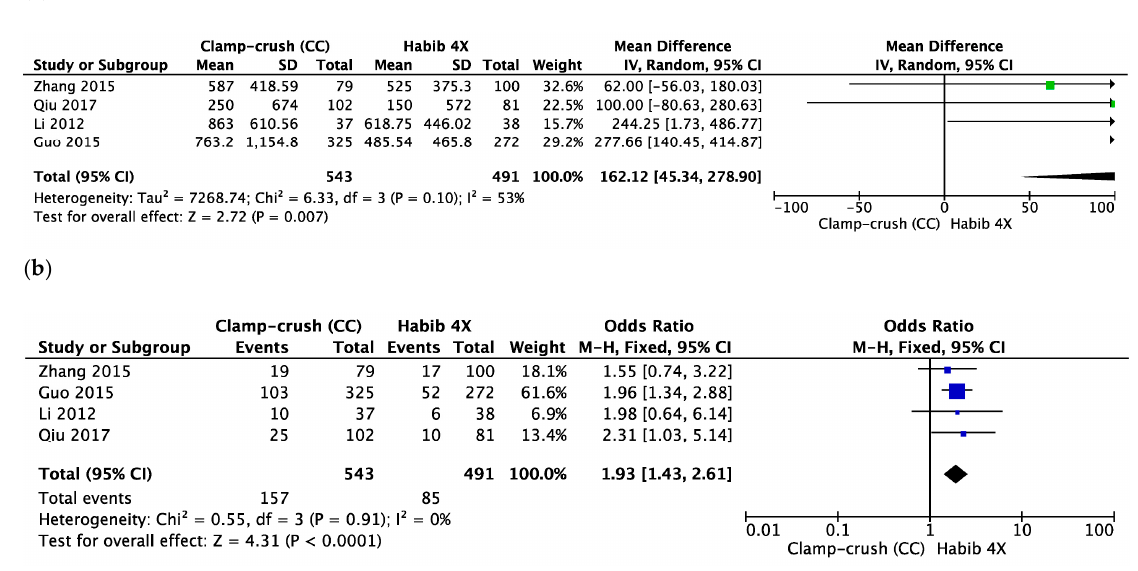
Figure 2. Forest plot representing the ( a ) total blood loss (mL), ( b ) number of patients requiring blood transfusion during liver resection comparing the control group (clamp-crush) with the study group (Habib™-4X). Squares’ size depicts the effects while comparing the weight of the study in the meta-analysis. The diamond shows the significant favour towards the study group (Habib™-4X) following the analysis. The 95 percent confidence interval is represented as horizontal bars.